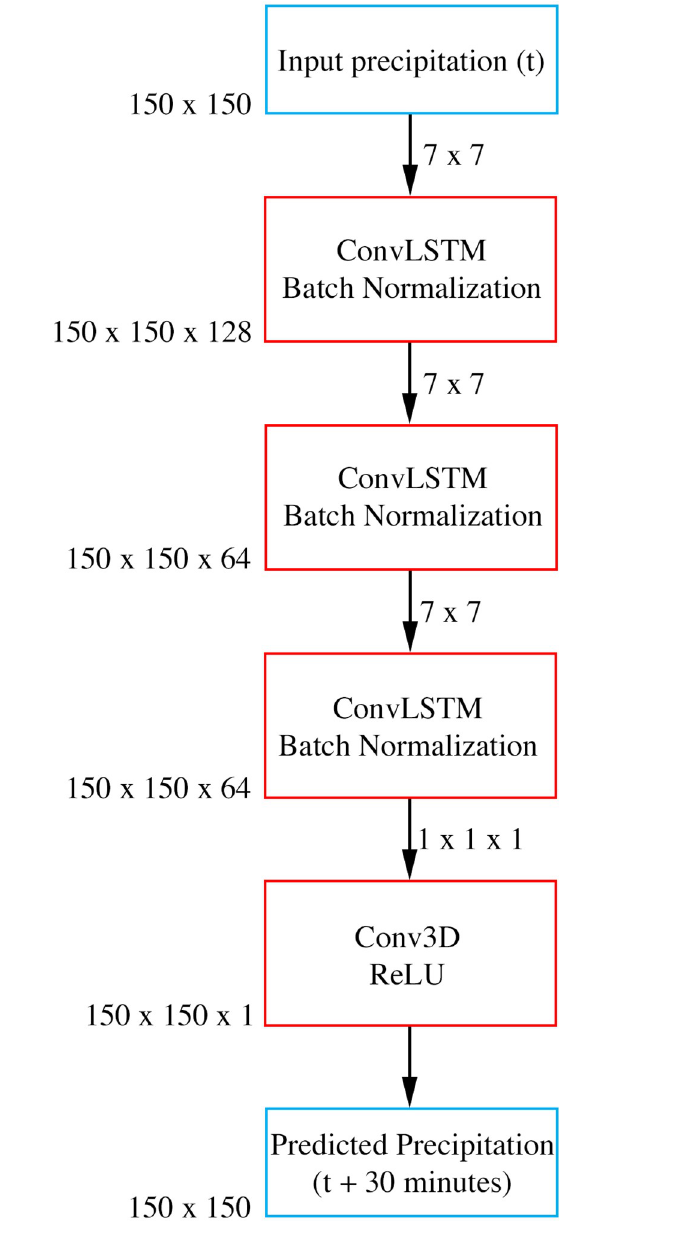
Fig 3. Convcast architecture for precipitation nowcasting using the IMERG dataset.